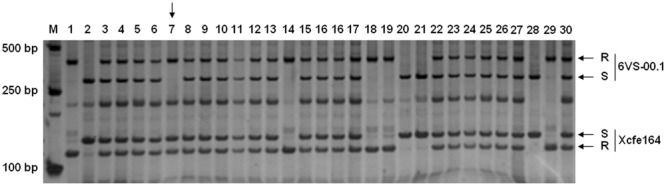
PCR amplification patterns in the F2 population using a double-PCR system with the markers 6VS-00.1 and Xcfe164. M: DNA marker DL2000; 1: the resistant parent DvRes-1; 2: the susceptible parent DvSus-1; 3–30: different F2 plants. R and S represent the DNA bands that were same to the resistant and susceptible parents, respectively. The vertical arrow indicates the recombinant individual.